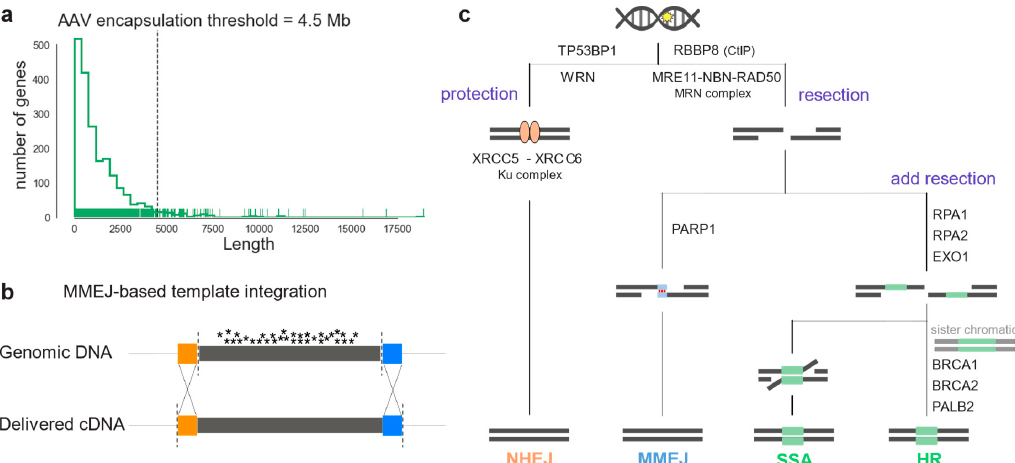
Figure 1. Large genomic portions can be corrected by in vivo genome editing relying on endogenous DSB repair pathways activity. ( a ) Coding sequence length of IRD genes listed in RetNet. The dashed line indicates the maximum cargo limit for AAV transfer. ( b ) Scheme illustrating homology-dependent genome engineering (HDR or MMEJ) to replace an entire mutation hotspot exon. Colored boxes (orange and blue) indicate homology regions. ( c ) DSB repair pathway diagram illustrating the enzymes listed in Table 1. After a DSB in the genomic DNA, the broken ends can be resectioned or protected. Protection by TP53BP1 or WRN , and Ku complex leads to NHEJ repair (orange). On the other hand, resection forms single-strand DNA overhangs that can reveal homology. Binding of PARP1 and the presence of micro-homology leads to MMEJ repair (blue). If resection is prolonged, repair is by SSA or HDR depending on the cell-cycle stage (green).